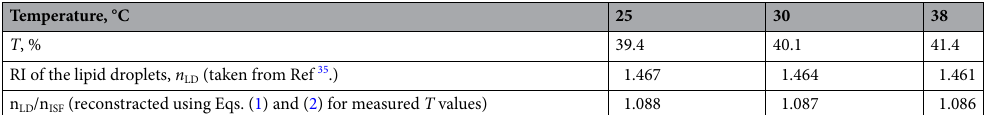
Temperature, °C 25 T , % RI of the lipid droplets, n LD (taken from Ref 35